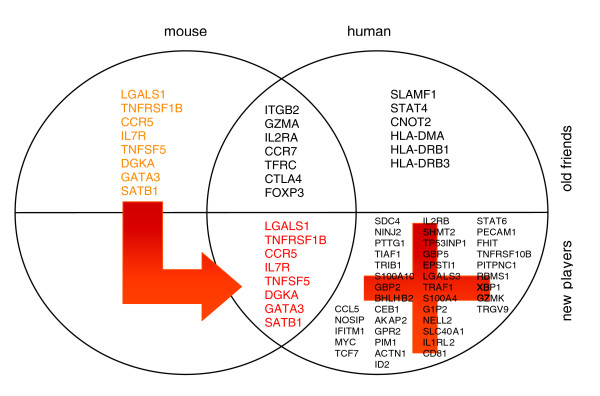
Old friends and new players. Genes differentially expressed in regulatory and naïve T cells, as identified by application of the Human TReg Chip. The upper half of the Venn diagram summarizes 'old friends'(namely, TReg cell associated genes that have previously been described in literature for either mouse or human). The lower half of the chart illustrates the new situation by showing all of the 'new players' of the TReg cell fingerprint. As demonstrated by the extended intersection, we identified eight genes, which formerly had only been implicated in mouse TReg cell immunology, as playing an additional role in human TRegcell activity (red arrow). Furthermore, our results expanded our knowledge on the transcriptional pattern characterizing human TReg cells by adding 41 new candidate genes (indicated by the red '+').